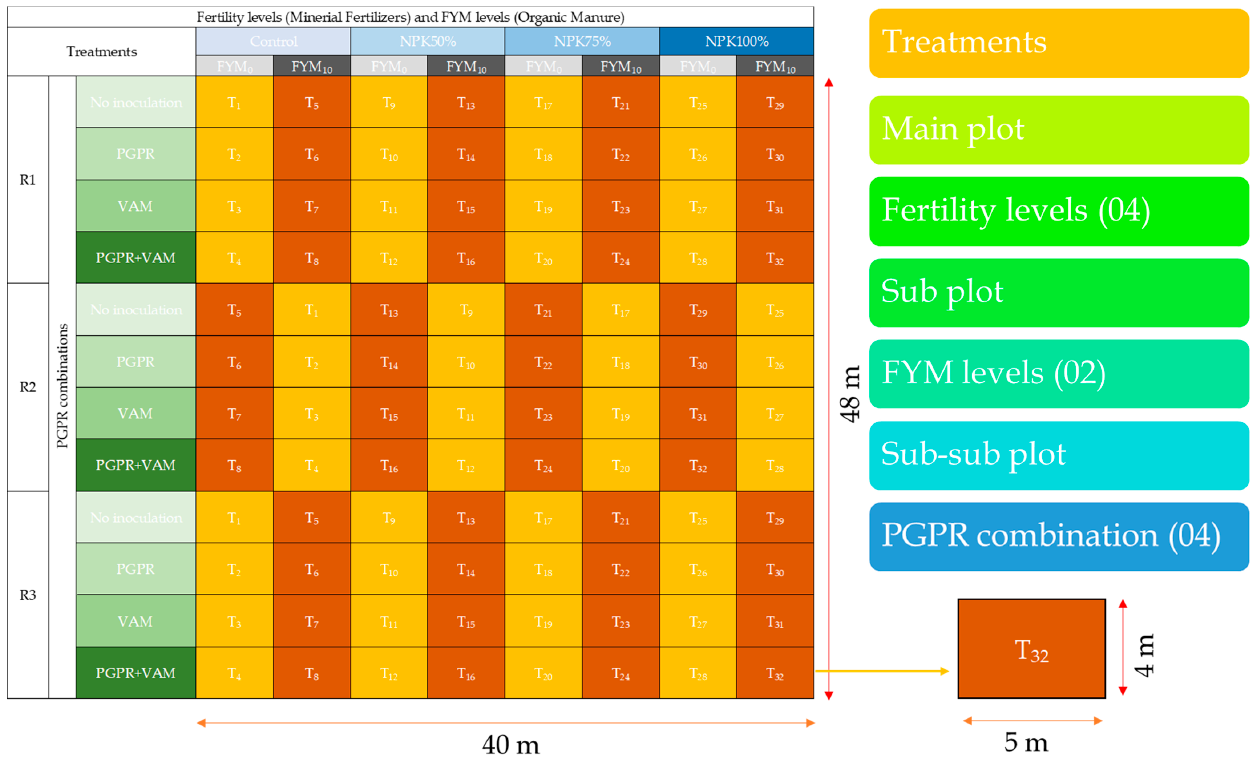
Figure 4. Two-year field experimental layout with treatment details (total number of plots: 96). Four levels of inorganic fertilizer (i.e., 0%, 50%, 75%, and 100% NPK) were